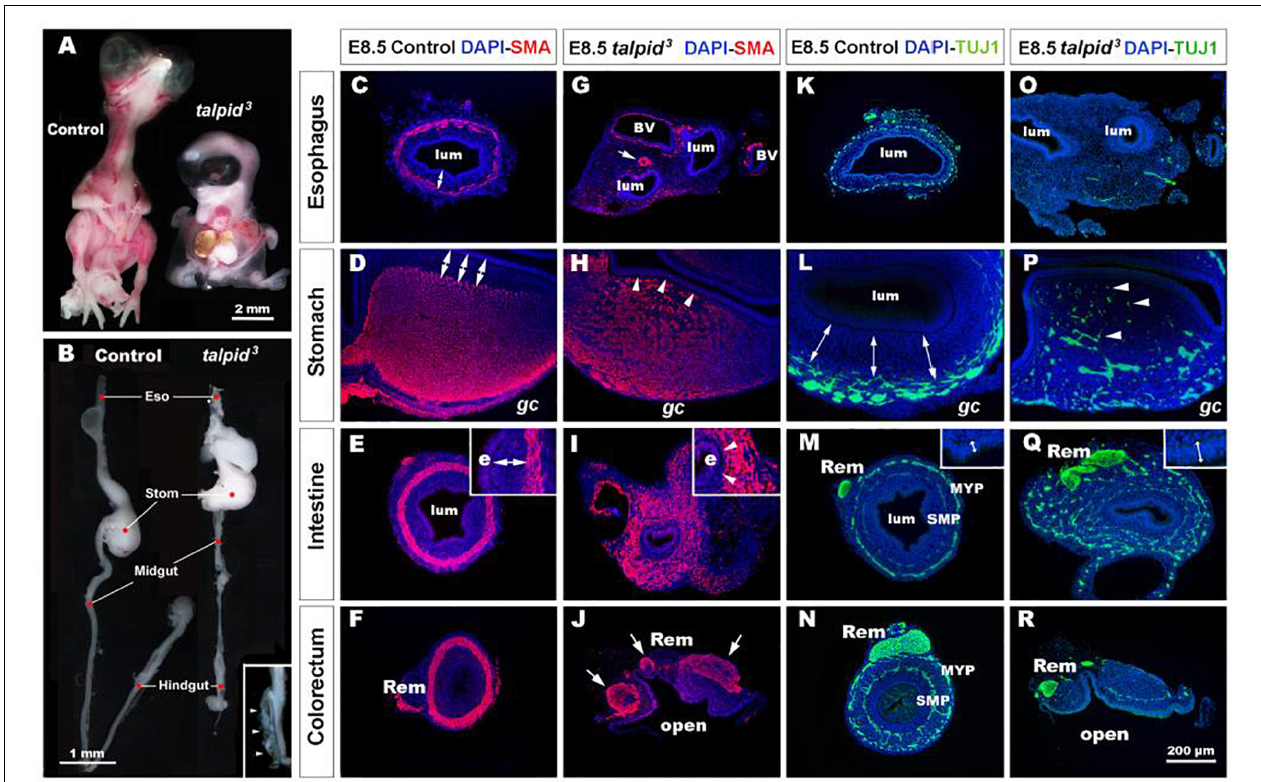
FIGURE 1 | talpid 3 embryos have multiple gastrointestinal defects, including disruption of the neuromuscular patterning of the digestive tract. (A) Phenotype of control (left) and talpid 3 (right) embryos at E10.5. talpid 3 mutant embryos have paddle-shaped limbs and hypotelorism. (B) Anatomical features of the GI tract along the rostro-caudal axis (esophagus, stomach, intestine, cecum, and colorectum) of E10.5 control embryos (left). In stage-matched talpid 3 embryos (right), all gut regions are apparent, but the esophagus and trachea are malformed, midgut and hindgut are reduced in length, and the terminal hindgut is open. (Inset in B ) High magnification of an open hindgut (arrowheads). (C–J) Expression of smooth muscle actin (SMA) at E8.5 in controls (C–F) and (G–J) talpid 3 embryos. (C–F) In controls, SMA is expressed in the presumptive circular muscle layer in the outer mesenchyme, distant from the epithelium ( C–E , double arrows). (G) In E8.5 talpid 3 embryos, the SMA staining of the esophagus is discontinuous unlike the SMA surrounding blood vessels (arrows). (H,I) SMA staining in the stomach and midgut of mutants is widespread throughout the gut wall, with staining extending adjacent to the epithelium (e) and the serosa (s) ( H,I , arrowheads). (J) SMA staining in the colorectum shows disrupted muscle and open hindgut. (K–R) Expression of TuJ-1 labeled enteric neural crest at E8.5 in (K–N) controls and (O–R) talpid 3 embryos. (K–N) In E8.5 controls, TuJ-1 staining shows enteric neural crest organized in one (K) or two plexuses (L–N) clearly separated from the mucosa (double arrows). (M,N) The Remak nerve is a single bundle of fibers. (O–R) In talpid 3 E8.5 embryos, TuJ-1 staining shows enteric neural crest cells are absent (O) or scattered throughout the mesenchyme ( P–R , arrowhead). The Remak nerve is divided in several bundles (Q,R) . Epithelium thickness varies between control and mutant intestine ( M,Q – inset). e, endoderm; gc , greater curvature of the stomach; lum, lumen; m, mucosa; Rem, nerve of Remak; MYP, myenteric plexus; SMP, submucosal plexus; BV, blood vessels. Same scale bar in (C–R)